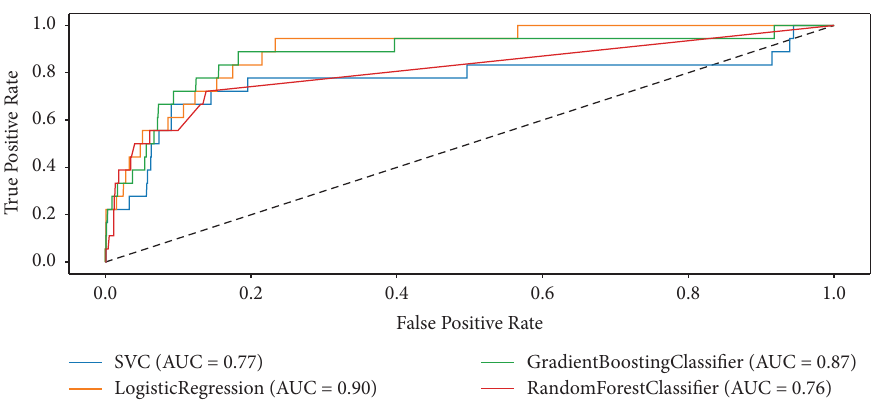
Figure 9: Roc_auc